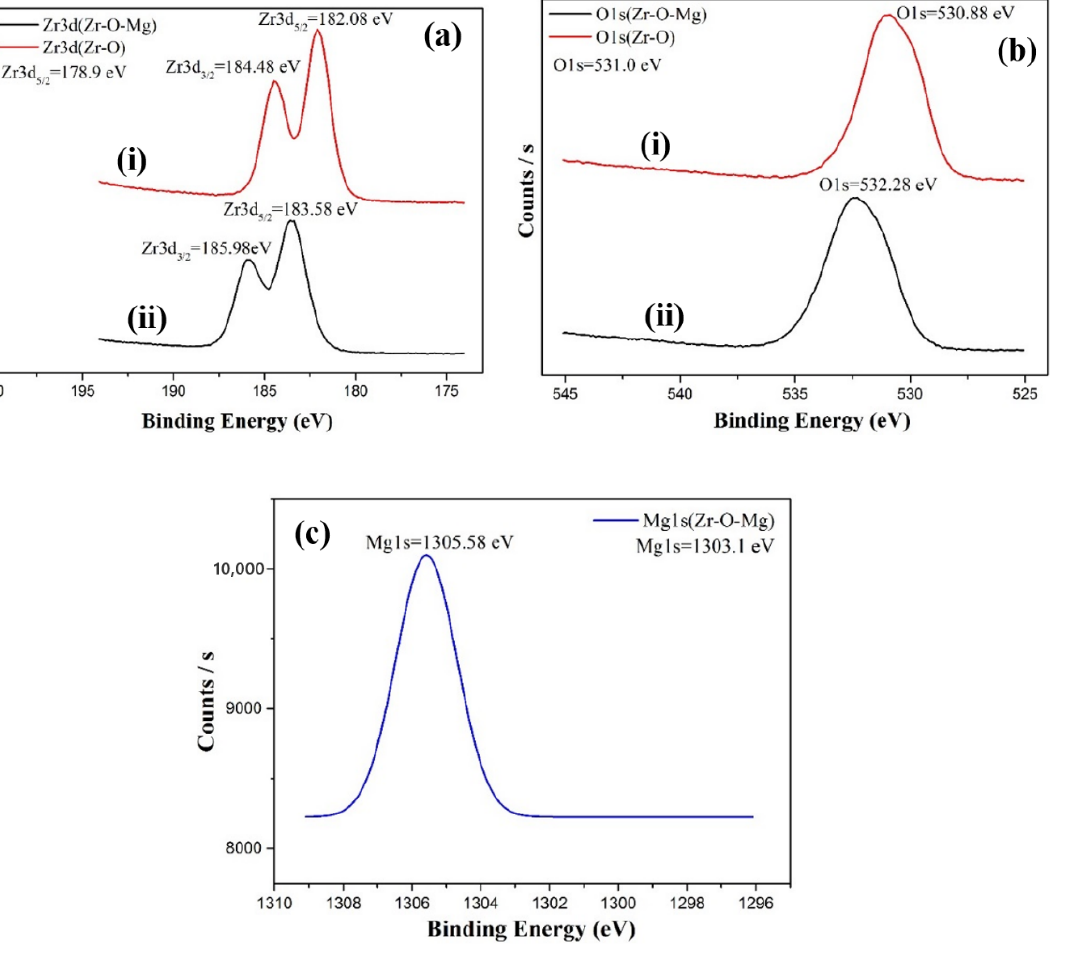
Figure 6. The ( a ) Zr 3d 1/2 , ( b ) O 1s, and ( c ) Mg 1s scanning curves of the XPS spectra for the (i) ZrO 2 aerogels and (ii) Zr–Mg mixed oxide aerogels with Zr/Mg molar ratio of 7/3. Figure 7 shows the PC yields of the CO 2 /PO cycloaddition reactions with different Zr/Mg molar ratios of Zr–Mg mixed oxide aerogels (10/0, 9/1, 8/2, 7/3, and 6/4) under reaction temperature of 150 ◦ C, the pressure of 10 kgW/cm 2 , and reaction time of 15 h. More clearly, the yield of PC significantly enhanced with the increase in Mg amount for the as-prepared Zr–Mg mixed oxide aerogels. The detailed data of the PO conversion, selectivity, and PC yield are given in Table 2. Zr–Mg mixed oxide aerogels with Zr/Mg molar ratio of 10/0 and the pristine ZrO 2 aerogel have large PO conversion of 91% and low PC selectivity of 9.4% because of rich Lewis acidic and fewer Lewis basic sites of the pristine ZrO 2 aerogels. When the amount of Mg is increased for the Zr–Mg mixed oxide aerogels, the PO conversions are slightly increased; however, the PC selectivity is